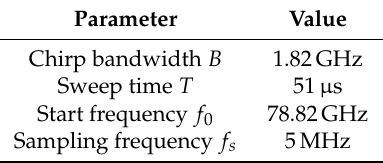
Table 1. Radar sensor configuration used to obtain the results in Section